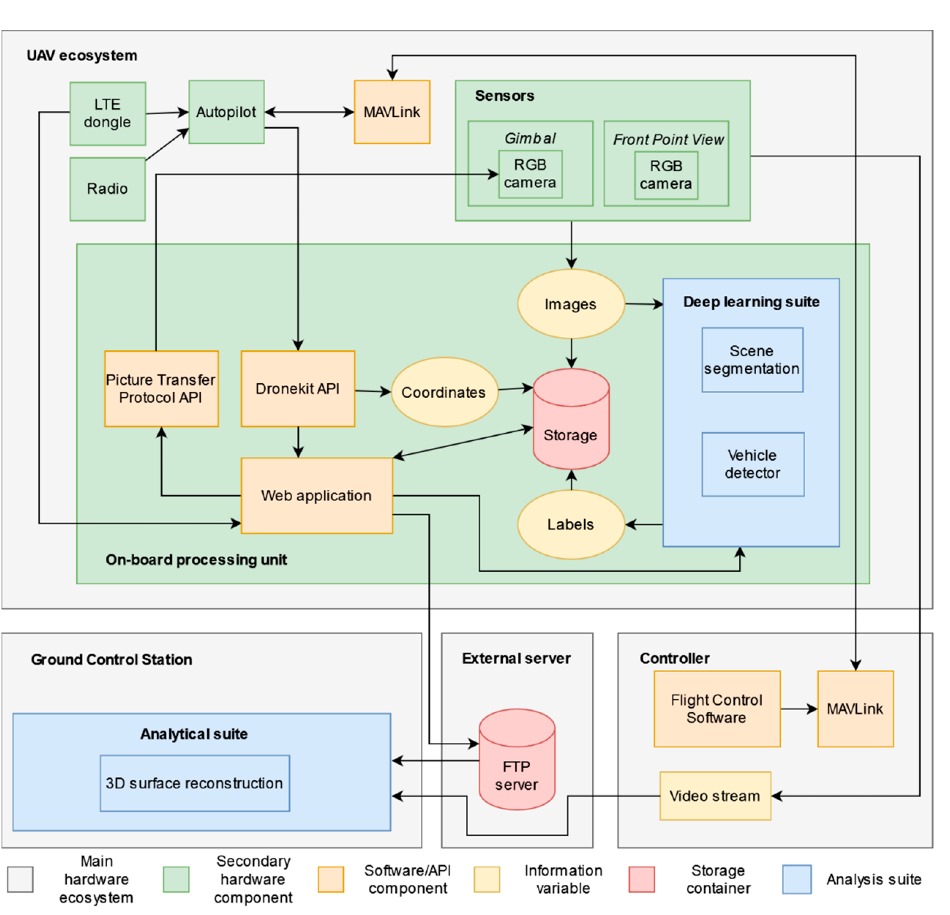
Figure 3. Detailed overview of the designed monitoring system showing the communication flow and protocol of hardware components and information.